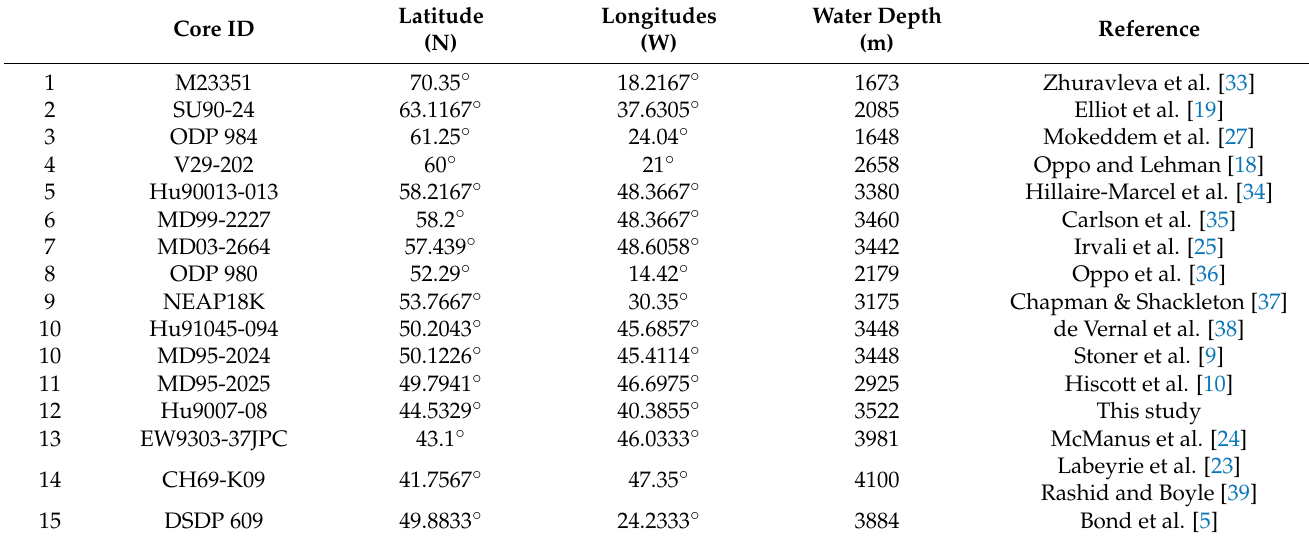
Table 1. Location of cores used in the